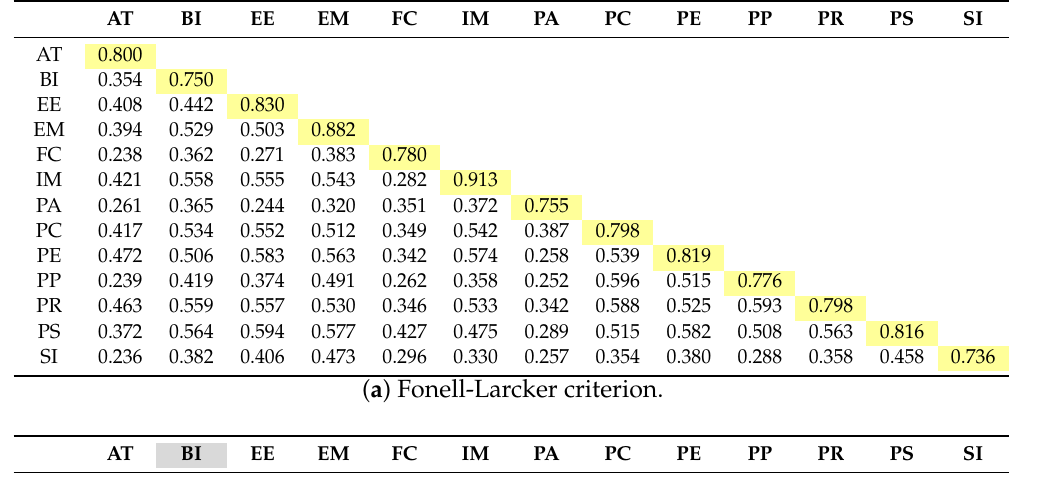
Table 4. Fornell–Larcker criterion and Cross